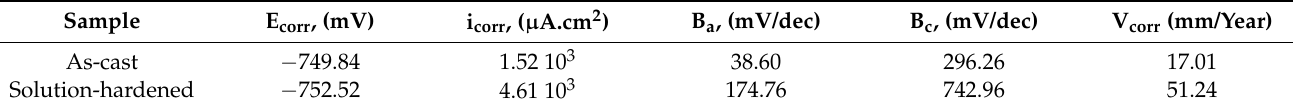
sequence. Abbreviations: the corrosion potential (E corr ), corrosion current density (i c ), anode slope (B a ), cathode slope (B c ), and corrosion rate (v corr and corrosion rate (v corr ).